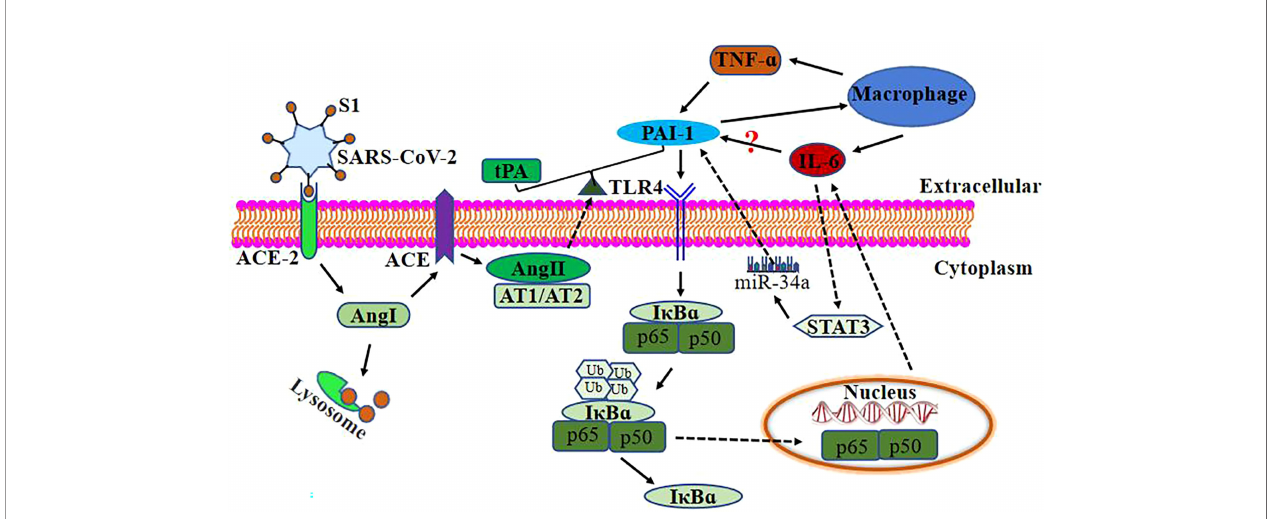
FIGURE 2 | Relationship between PAI-1 and IL-6 after SARS-Co-2 infection. SARS-CoV-2 binds to ACE-2 on the target cell surface, resulting in the loss of ACE-2. ACE-2 is a negative regulator that works by activating tPA. ACE-2 de fi ciency loses the effective ACE-2/angiotensin (1 – 7)/Mas receptor axis and increases the level of Ang1. ACE converts Ang I to Ang II and decreases tPA activity, causing endothelial cells and smooth muscle cells to synthesize and release PAI-1. Ang II binds to AT1/AT2 to break the balance of PAI-1/tPA to its prethrombotic state. Elevated levels of PAI-1 in severely and critically ill COVID-19 patients may upregulate IL-6 expression through TLR4/NF- k B pathway and activate macrophages to upregulate IL-6 and TNF- a expression. At the same time, TNF- a can also upregulate PAI-1 expression. IL-6 upregulates the expression of PAI-1 via STAT3/miR-29a.